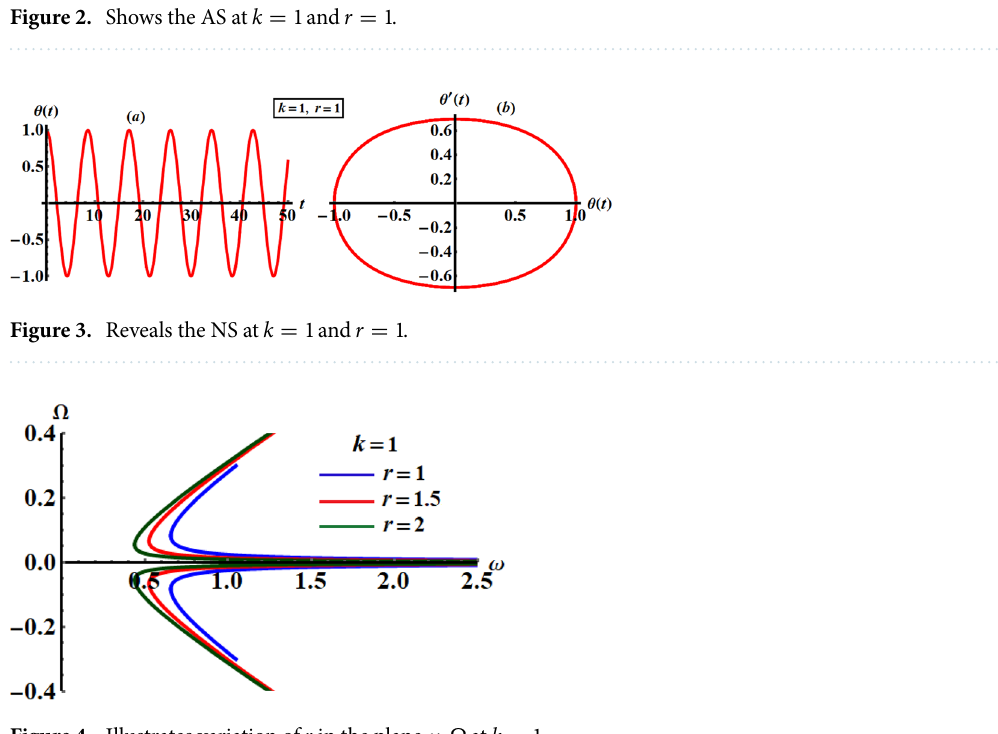
Figure 4. Illustrates variation of r in the plane ω c � at k = 1